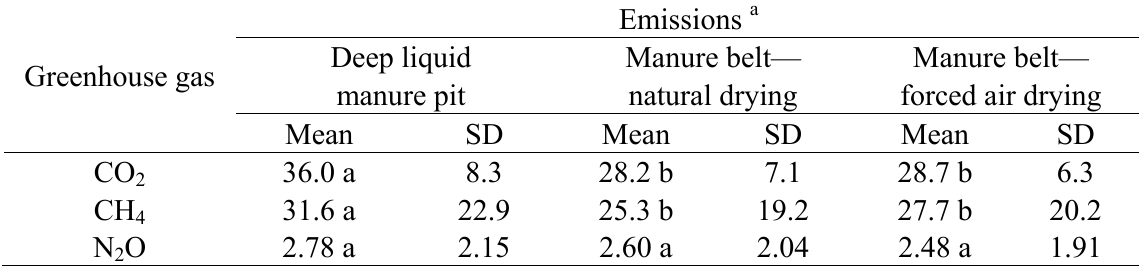
Table 4. Mean carbon dioxide (kg yr − 1 hen − 1 ), methane (g yr − 1 hen − 1 ) and nitrous oxide (g yr − 1 hen − 1 ) emissions from the three housing